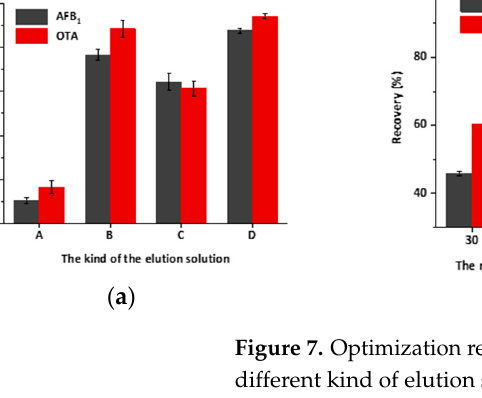
Table 3. Column capacity and preservation rate of AFB 1 and OTA in 7 cycles ( n = 3).